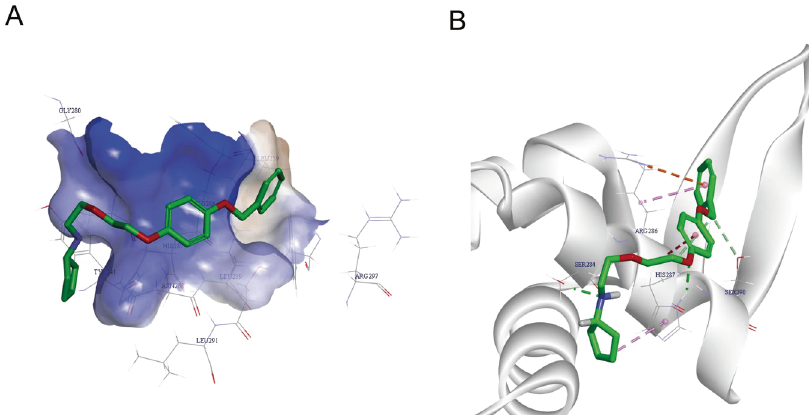
Fig. 3 Potential binding mode of XST-20 with FOXM1 DNA binding domain. A The orientation of XST-20 in the active site of FoxM1. The co- crystal ligand is represented as stick diagrams with carbon atoms in green. Amino acid residues surrounding the active site are shown inline. B The binding mode of XST-20 in the active site of FoxM1. The ligand is represented as stick diagrams with carbon atoms in green. Relevant amino acid residues in the binding site are shown inline. Green dashed lines represent conventional hydrogen bond interactions. Pale green dashed lines represent carbon – hydrogen bond interactions. Pink dashed lines represent Pi – alkyl interactions. Red dashed lines represent Pi – cation